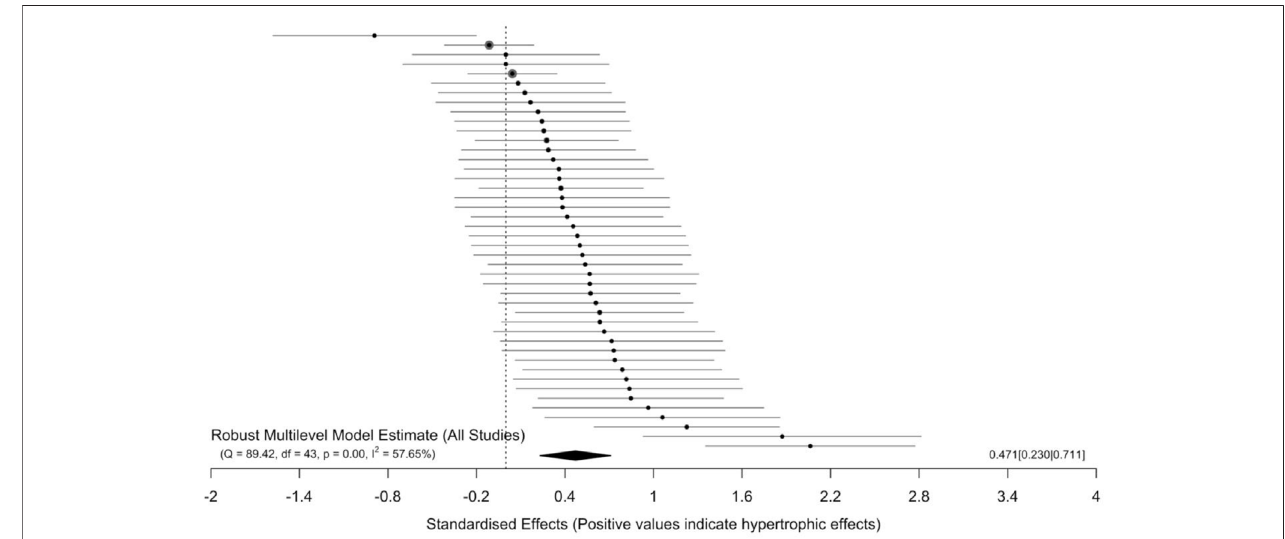
FIGURE 2 | Ordered caterpillar plot of all effects.